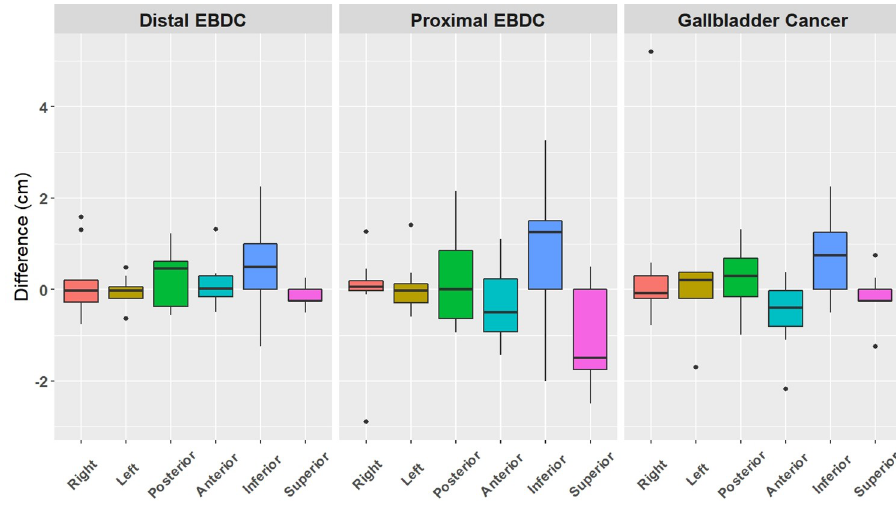
Fig 2. Plots of differences of borders in six directions between each clinical target volume (CTV) delineated by 9 radiation oncologists and CTV with confidence level of 80% generated by STAPLE.